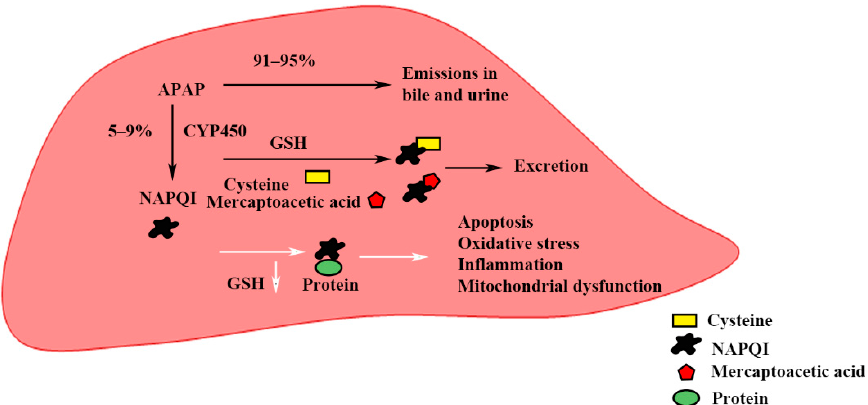
Figure 1. Schematic diagram of APAP-induced hepatotoxicity. NOPQI is metabolized in combination with cysteine and mercaptoacetic acid when GSH is abundant. With the depletion of GSH, the accumulated NAPQI binds to some large proteins to induce mitochondrial damage, oxidative stress, an inflammatory response, and apoptosis.